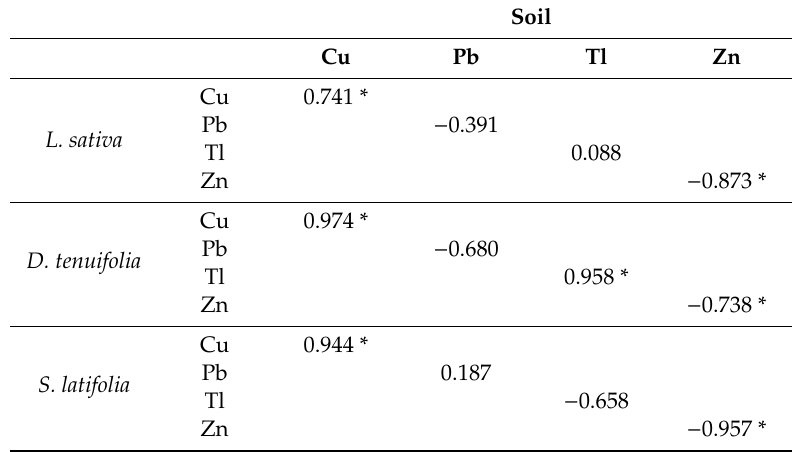
Table 6. Pearson correlation coe ffi cients showing the relationship between the promptly available content of PTEs in soil and concentration of PTEs in aerial plant biomass.